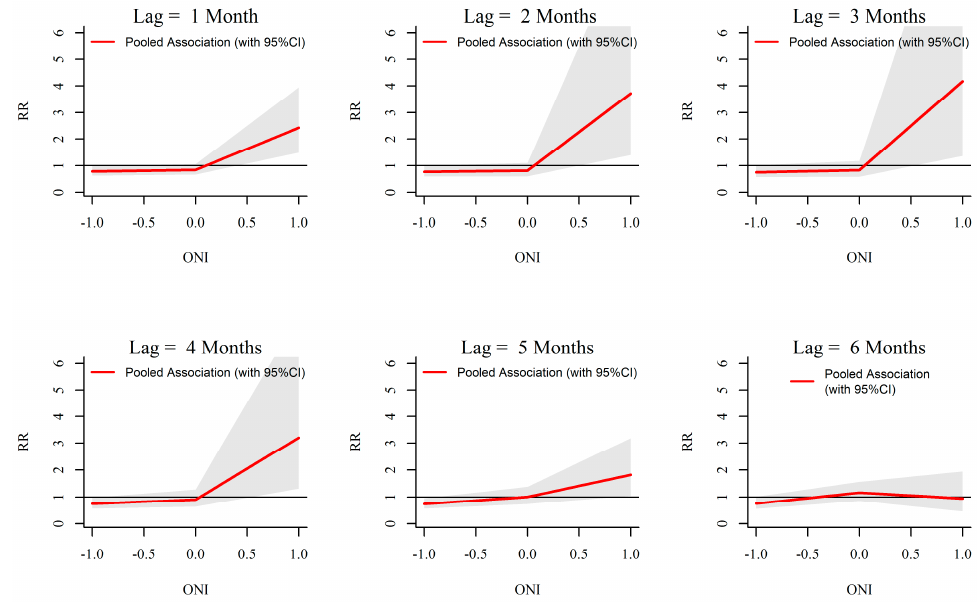
Figure 10. Relative risk (RR) of monthly mean rainfall by ONI at specific lags in 10 MOH divisions in Kalutara district, Sri Lanka, 2009–2013. The figure illustrates the predicted curves from meta-regression for different lag periods; 1, 2, 3, 4, 5 and 6 months. The shaded areas represent 95% confidence intervals.